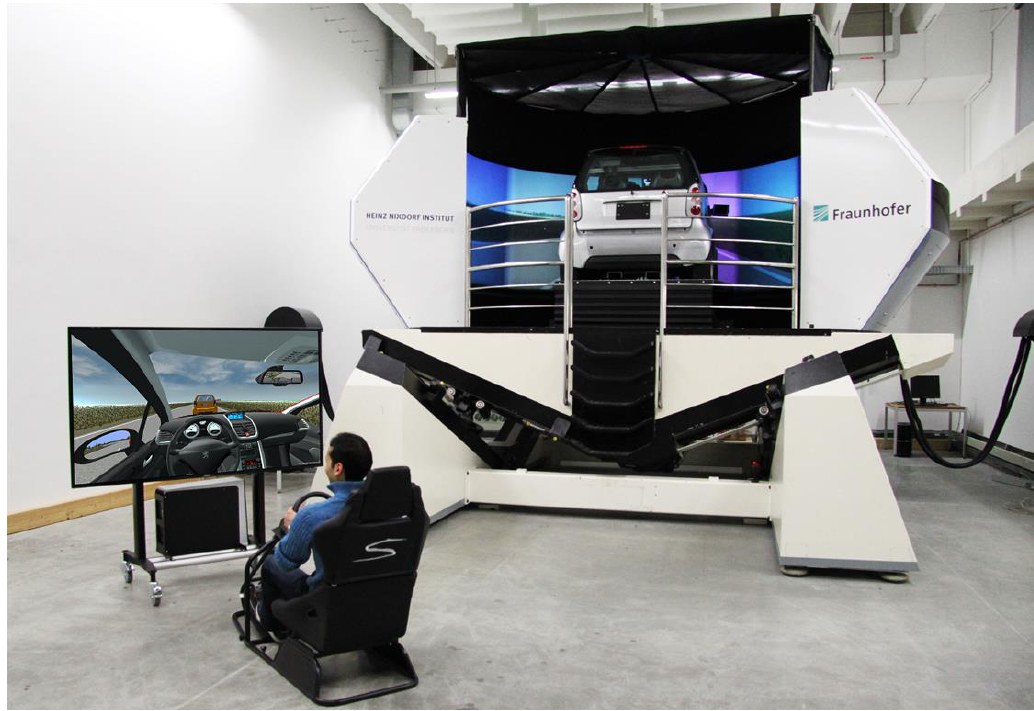
Figure 14. Established platform of networked driving simulation for the first application scenario.